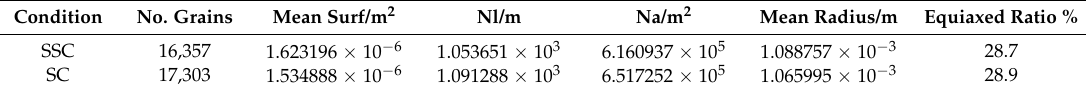
Table 5. Statistic grain parameters under different cooling conditions (1/4 cross section).